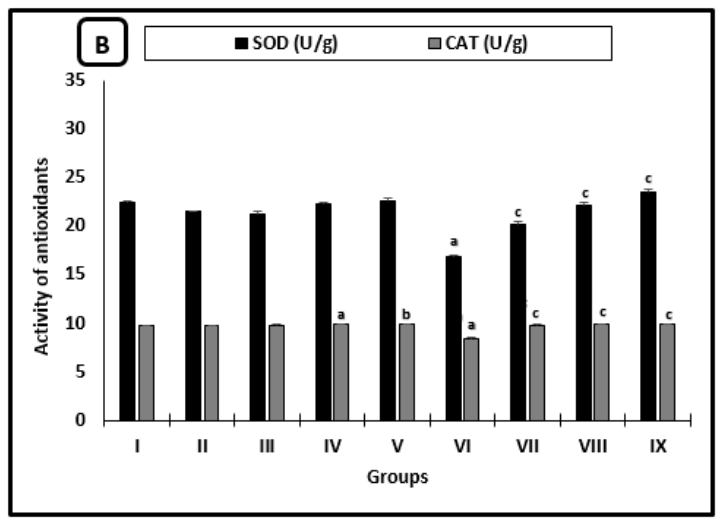
Figure 4. Liver antioxidant changes of mice after 2 weeks of treatment. ( A ) GSH levels and GST activity. ( B ) SOD and CAT activities. a significant difference from the saline group, b significant difference from the phosphate buffer group, c significant difference from the infected-untreated group. Groups I, II, III, IV, and VI presented saline, PB, PZQ, AL, and CU uninfected treated mice, groups VI, VII, VIII, and IX presented infected-untreated mice, and PZQ, AL, and CU presented treated mice.